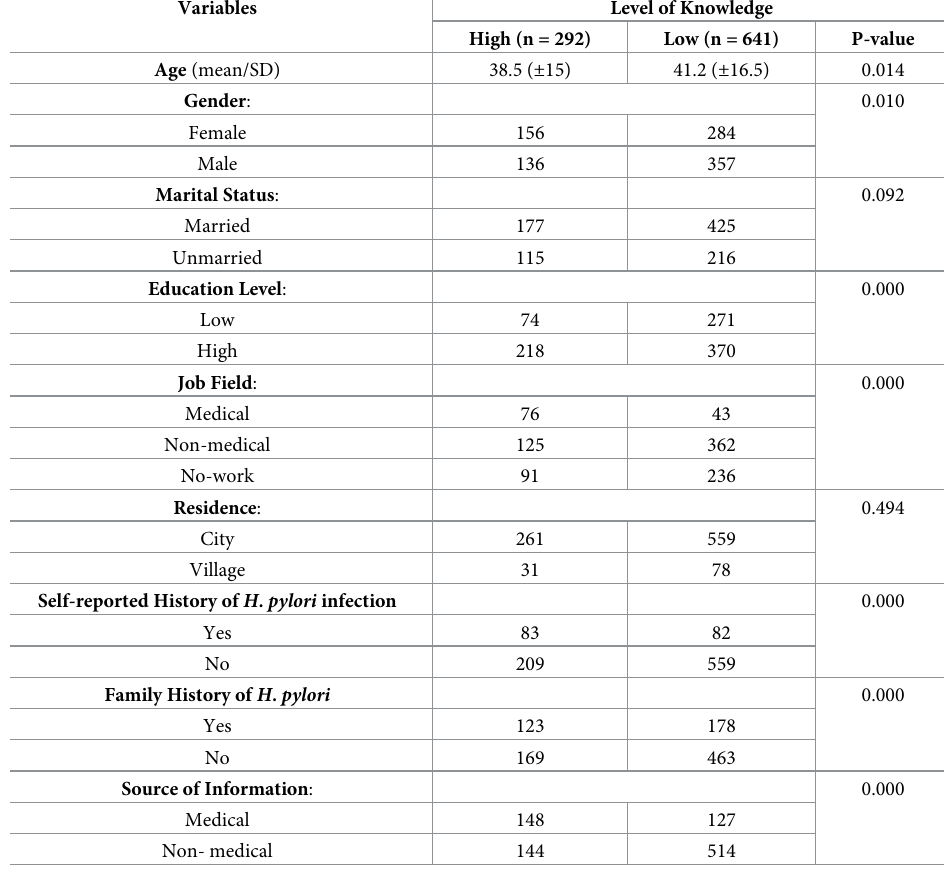
Table 2. Association between sociodemographic characteristics of the general population and knowledge about H . pylori (n =